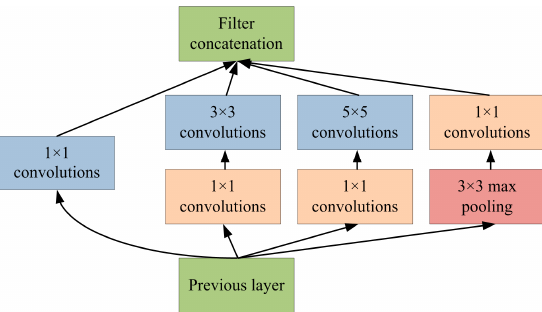
Figure 1. Inception module in GoogLeNet. Remote Sens. 2017 , 9 , 225